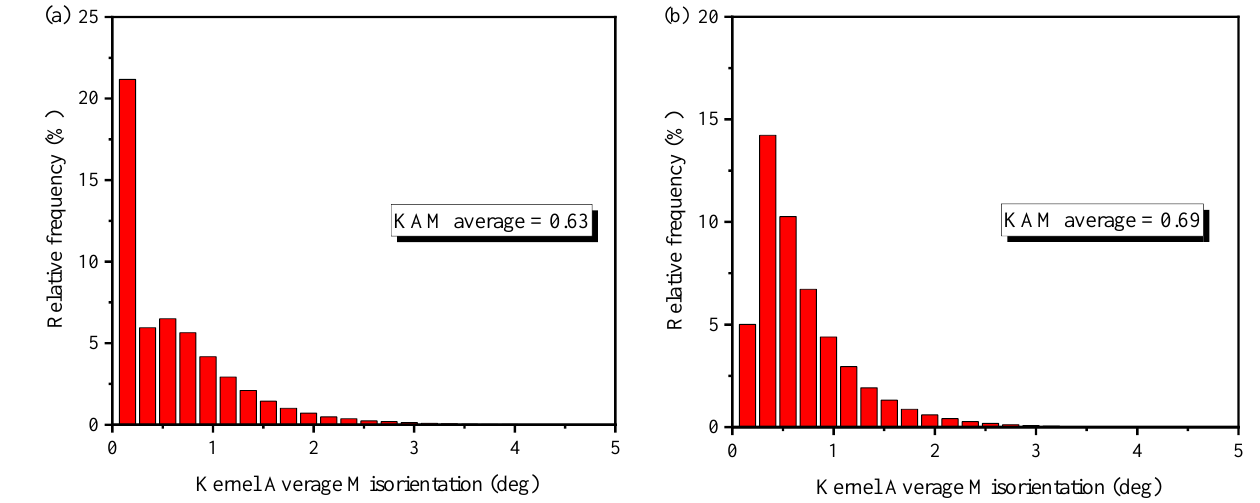
Figure 5. The average values of KAM after ( a ) FT and ( b ) LPB processes.